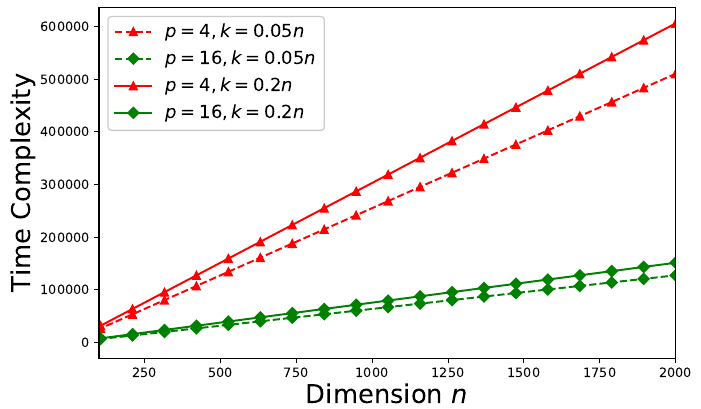
Figure 10. Time-complexity versus the number of processors p and the dimension k subject to (cid:101) = 10 − 5 for an inconsistent system ( m = 1.25 n